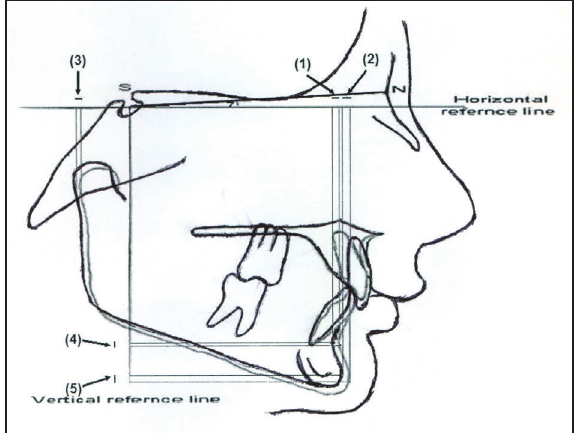
(5)"""'" I V rtic",1 rC?fpornc<? Figure 3. Sagittal and Vertical changes in B, Pogonion, and Articulare points: (1), Sagittal change in B point; (2), Sagittal change in Pogonion point; (3), Sagittal change in Articulare point; (4), Vertical change in B point; (5), Vertical change in Pogonion point.